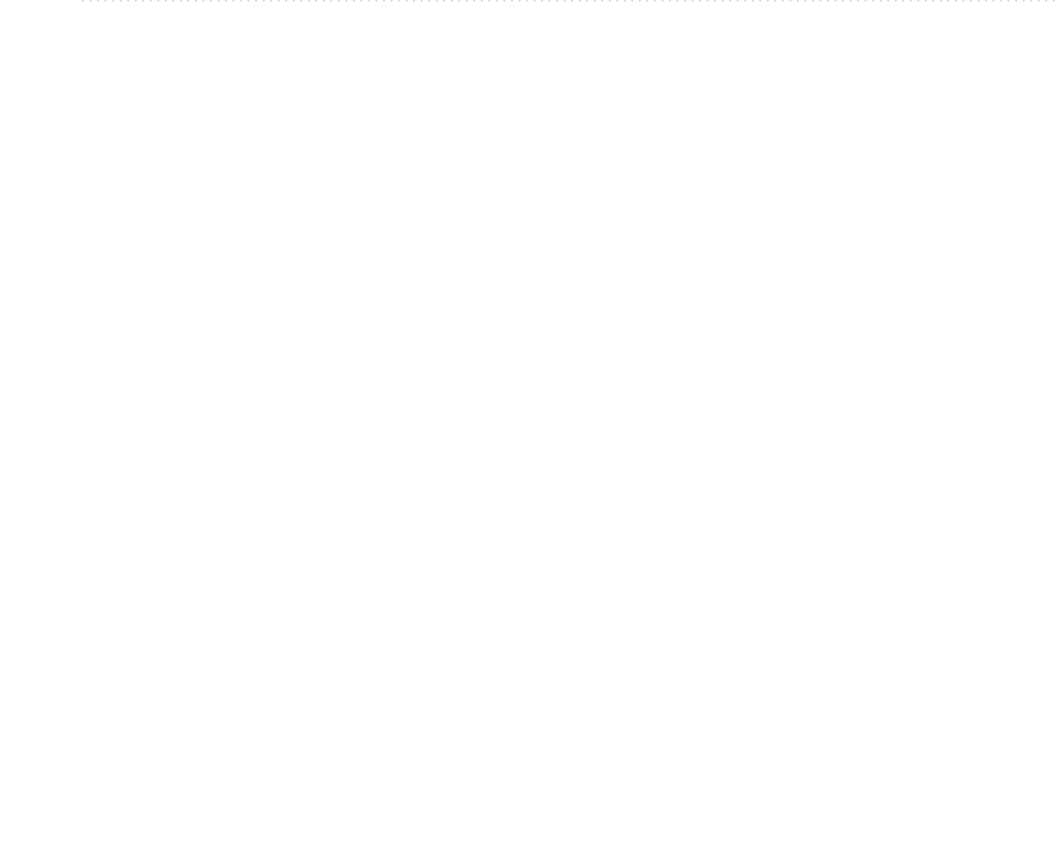
Figure 5. Concentration profile φ(η) for varying values of ( a ) magnetic parameter ( M ) with S 3 = 1 and in ( b ) for varying values of S 3 with M = 1 for suction case ( V C = 1 ) with Da − 1 = (cid:31) = 1 , Sc = 2 , S 1 = 1, S 2 = − 1 , ϕ 1 = 0.1, ϕ 2 = 0.04